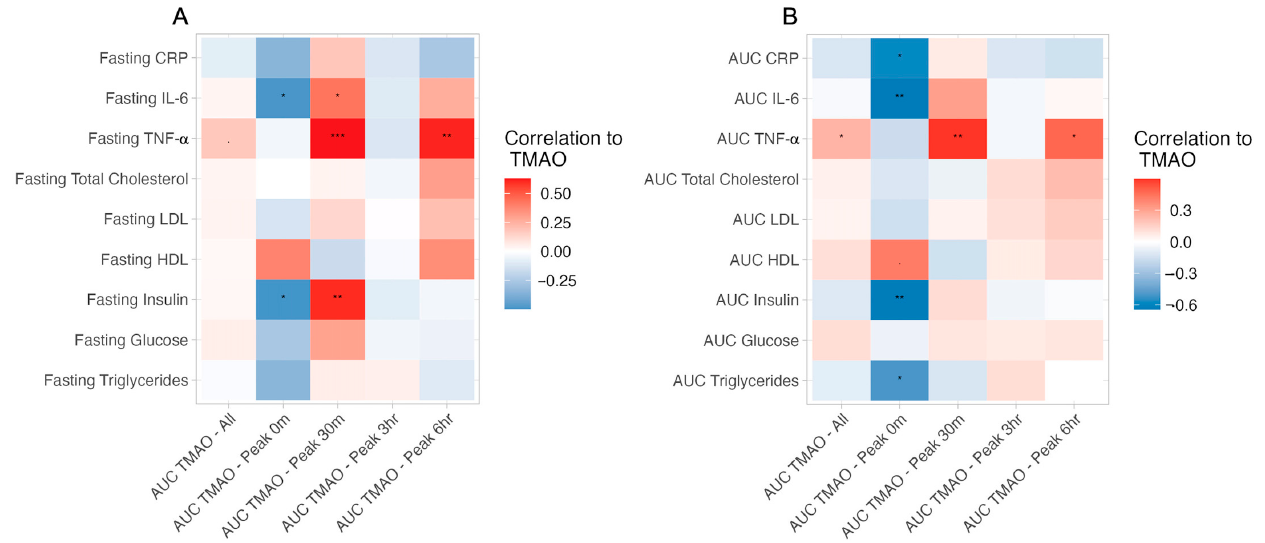
Figure 6. Relationships between cardiometabolic biomarkers and TMAO. Relationships between cardiometabolic biomarkers and exposure to TMAO (AUC-TMAO) by TMAO-response group identify similar relationships between fasted versus cumulative (AUC) concentrations. Assessing relationships by TMAO-response groups reveals relationships hidden when assessing the whole cohort. ( A ) The correlation between AUC-TMAO concentration and fasting cardiometabolic markers. ( B ) The correlation between AUC-TMAO and AUC-cardiometabolic markers. Red indicates a positive relationship and blue indicates a negative relationship. Correlations were calculated using the Spearman method. *** p < 0.001, ** p < 0.01, * p < 0.05, · p < 0.1.